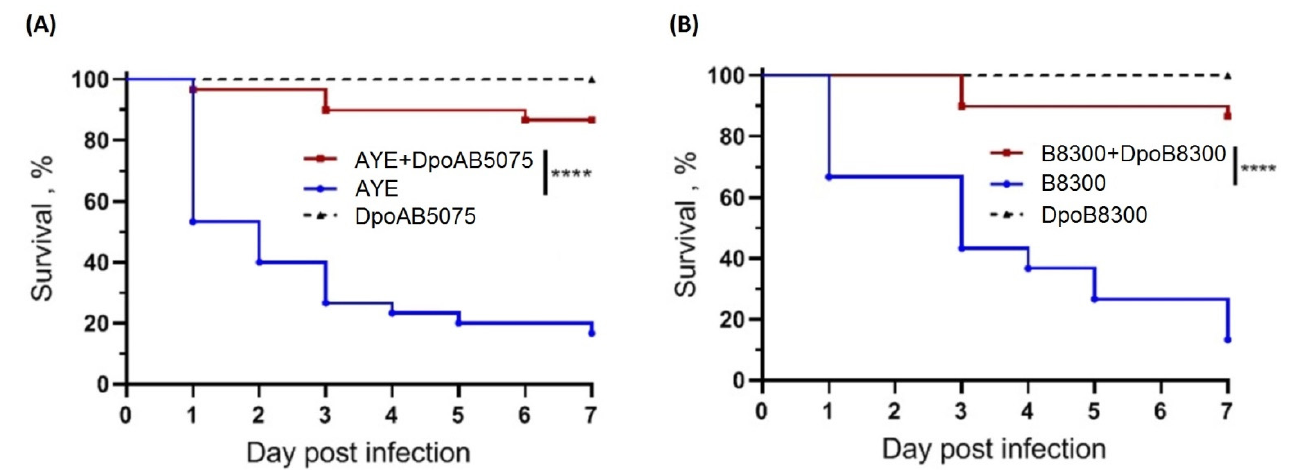
Figure 7. Kaplan–Meier survival curves following injection of G. mellonella larvae with A. baumannii strains treated and non-treated with depolymerases. ( A ) Larvae treatment with 1 × 10 6 CFU of A. baumannii AYE; ( B ) Larvae treatment with 1 × 10 7 CFU of A. baumannii B8300. Larvae ( n = 30) were injected with either bacteria or bacteria simultaneously with the enzyme DpoAB5075 or DpoB8300 (2 µ g per larva). The experiments were controlled by observation of uninfected larvae, larvae injected with saline solution, and larvae receiving the depolymerase only. Survival for each control group was 100%, so for simplicity, a group of uninfected larvae, and larvae injected with the saline solution, were not included in the figure. Statistically significant differences in survival between larvae infected with bacteria only and larvae infected with bacteria simultaneously with depolymerases were estimated by the log-rank (Mantel–Cox) test (**** p < 0.0001).